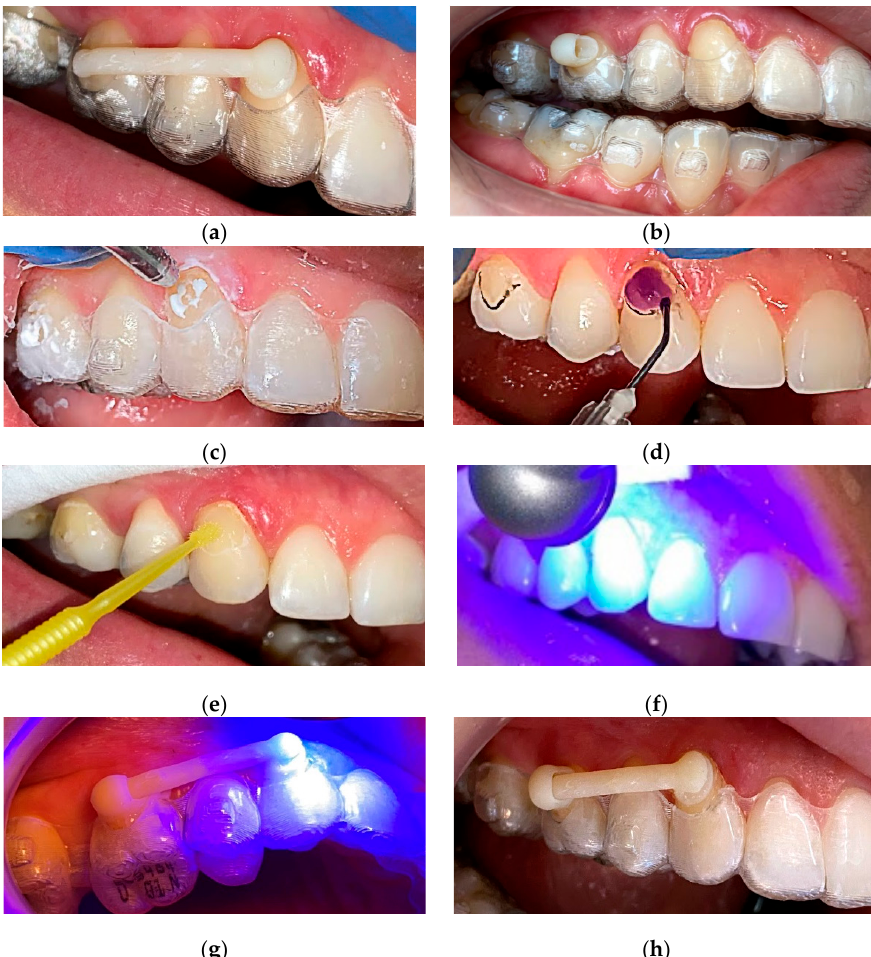
Figure 15. Clinical application of a personalized 3D printed distalizer in combination with CAT (Invisalign ® ); ( a ) Initial “try-out” of the mesial part of distalizer with its “arm”; ( b ) “try-out” of the distal smaller part of distalizer; ( c ) circular sandblasting 5 s each of the surface; this is proven to significantly increase bond adhesion strength [67]; ( d ) standard enamel etching with 37.5% phos- phoric acid, rinsing and drying; ( e ) application of 7th generation Single Bond Universal from ESPE; ( f ) Standard Light curing of the bond; ( g ) Standard Light curing for final adhesion of the distalizer with a micro layer of 3M™ Transbond™ PLUS Color Change Adhesive; ( h ) final appearance of the distalizer before activation.